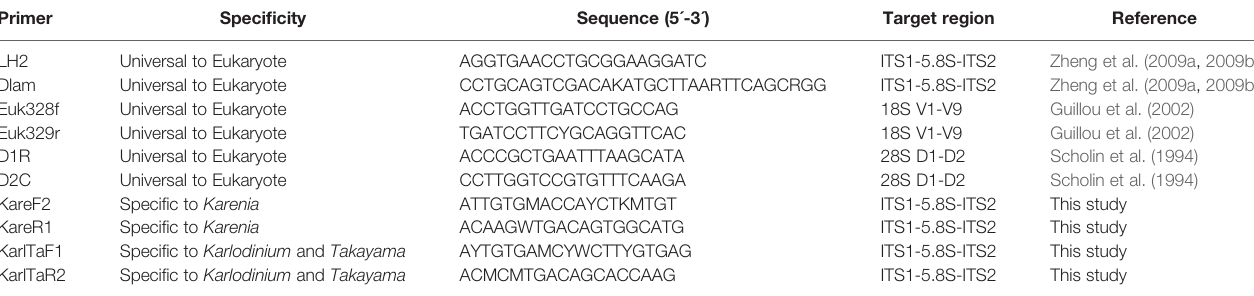
TABLE 2 | Summary of primers used in this study.